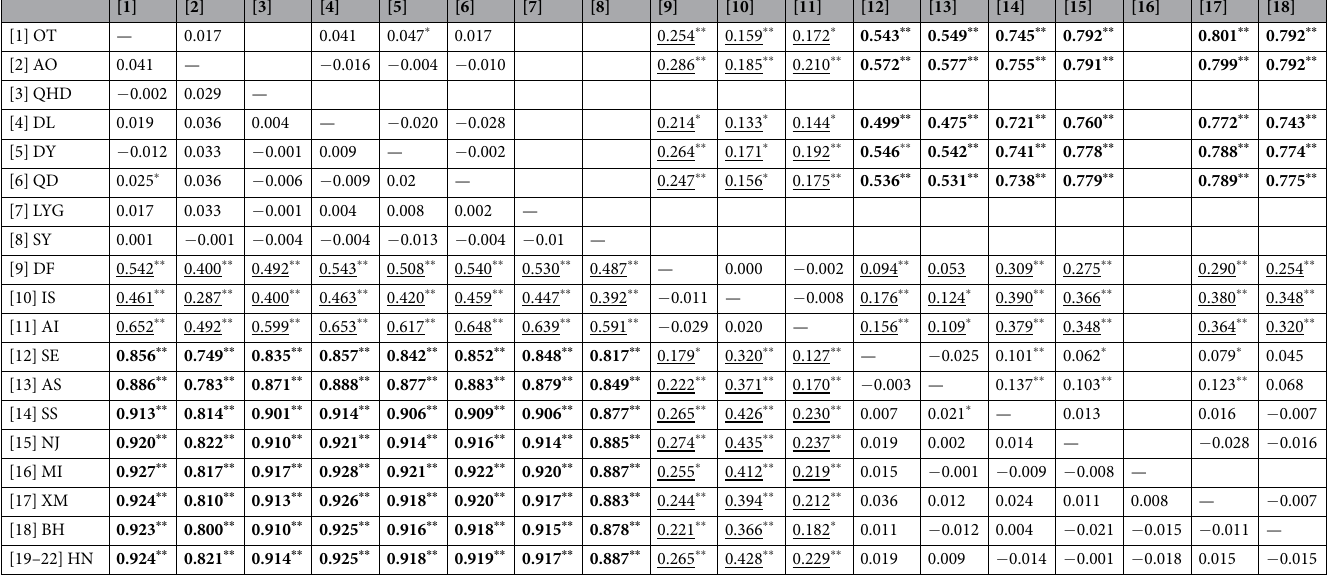
Table 2. Pairwise F ST comparisons between populations inferred from mtDNA COI (below diagonal) and nrDNA ITS (above diagonal). * P < 0.05; ** P < 0.001.